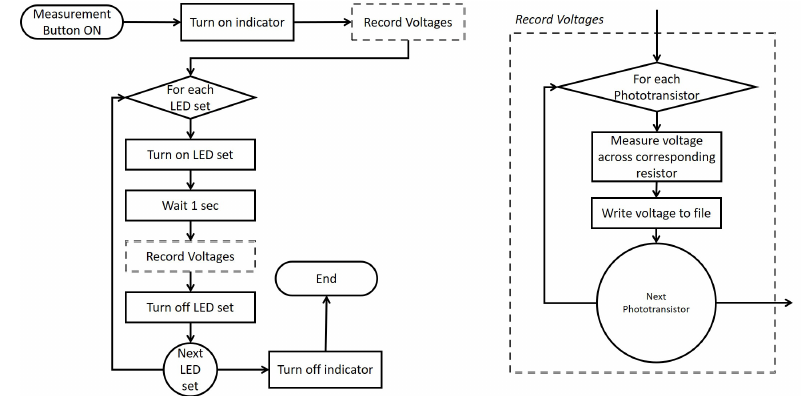
Figure 4. The D-SPARC data collection